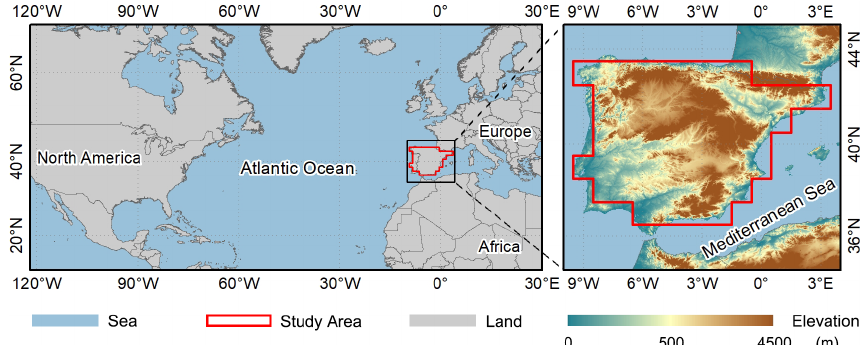
Figure 1. Map of the IP (the area enclosed by the red line) on a grid of 1 ◦ × 1 ◦ as the target